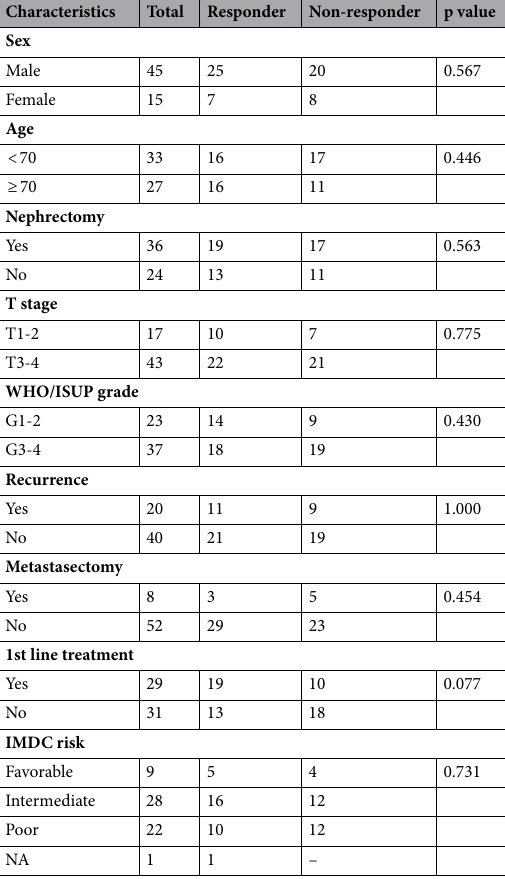
Table 1. Baseline characteristics and Fisher’s exact test results. ISUP international society of urological pathology, IMDC international metastatic renal cell carcinoma database consortium. Responders: patients with CR, PR, or SD ≥ 10 months. Non-responders: patients with PD or SD < 10